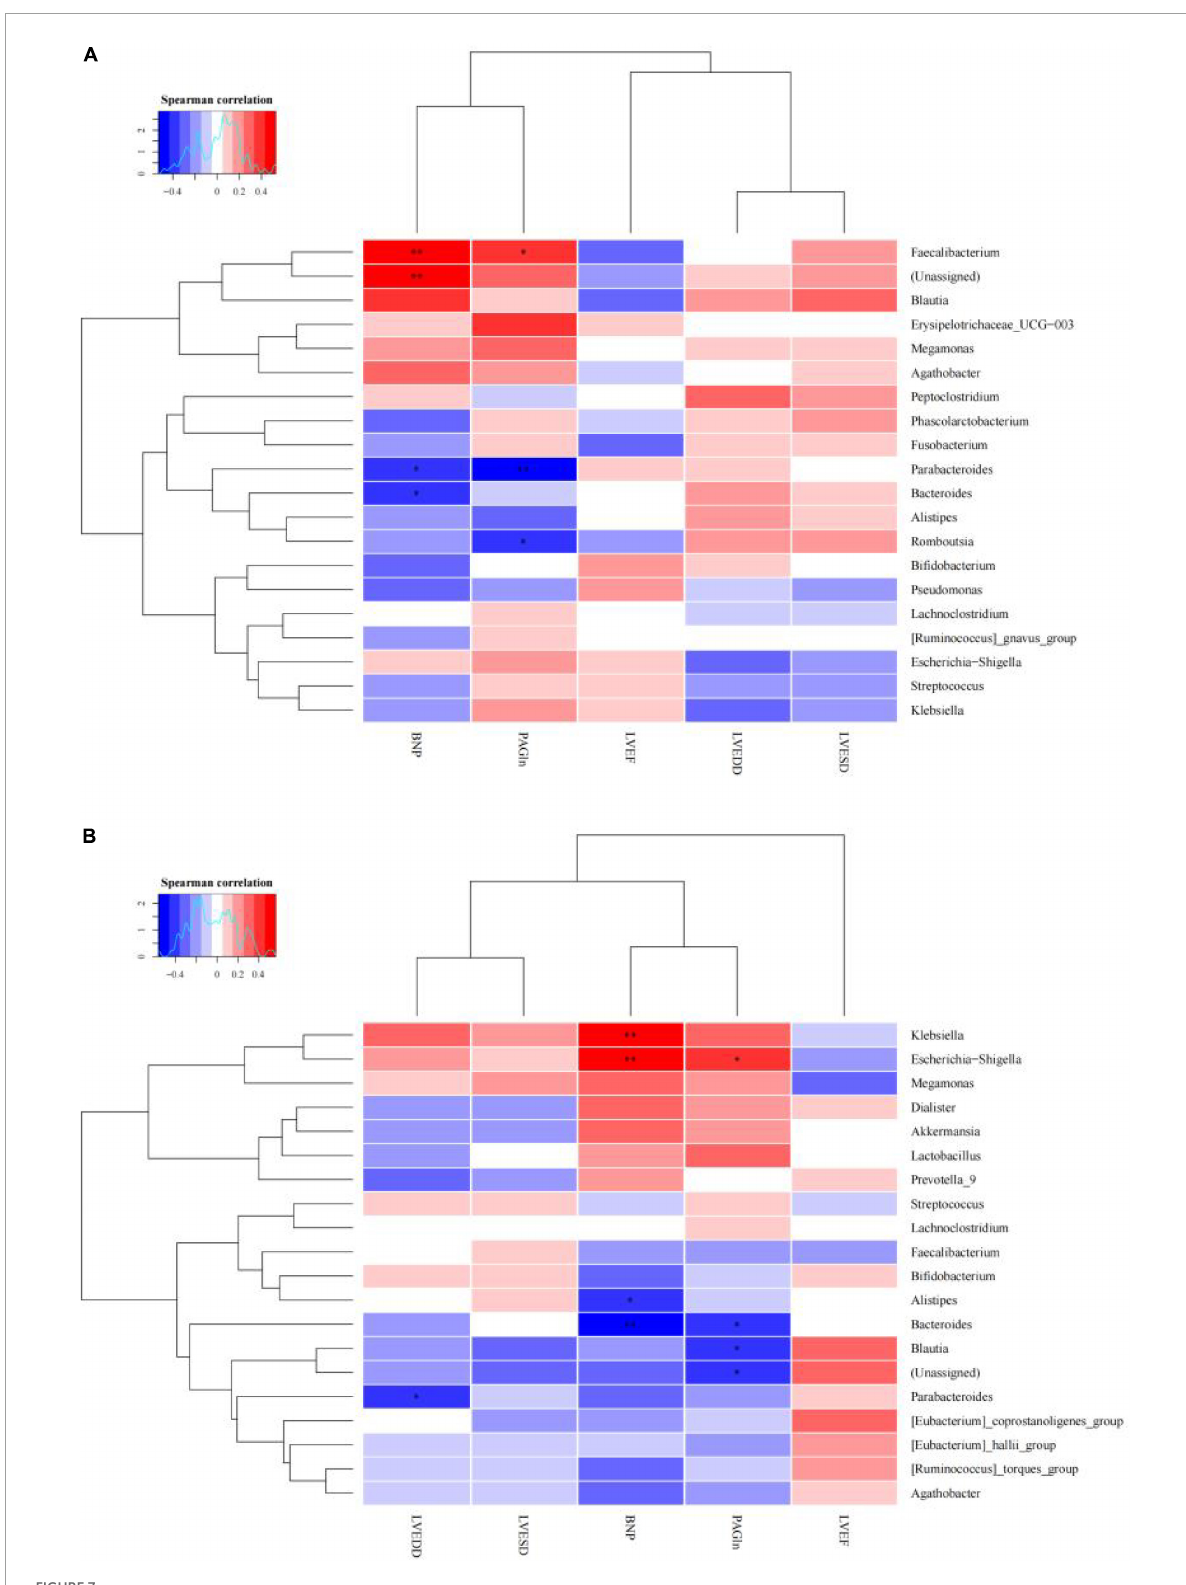
FIGURE7 Correlation heat map of the dominate microbes and clinical data concentration (* p < 0.05, ** p < 0.01). (A) New York Heart Association (NYHA) class III. (B) NYHA class